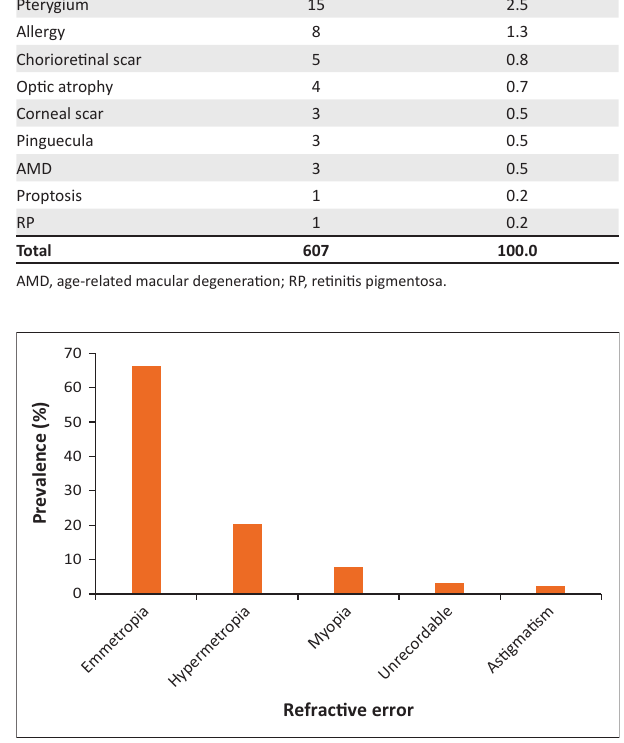
FIGURE 1: Prevalence of refractive